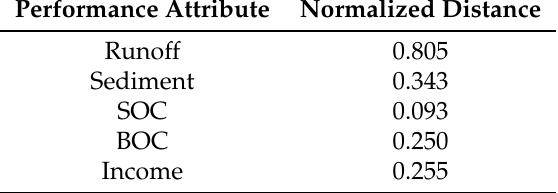
Table 14. Normalized distances of the solution produced by BIOLP when considering income and carbon stock